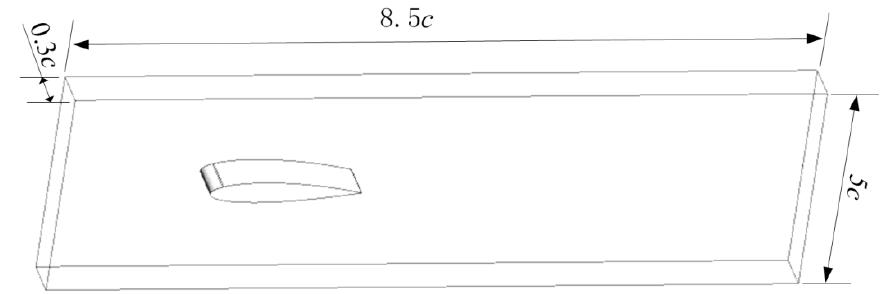
Figure 1. Computational domain and boundary conditions for NACA0015.